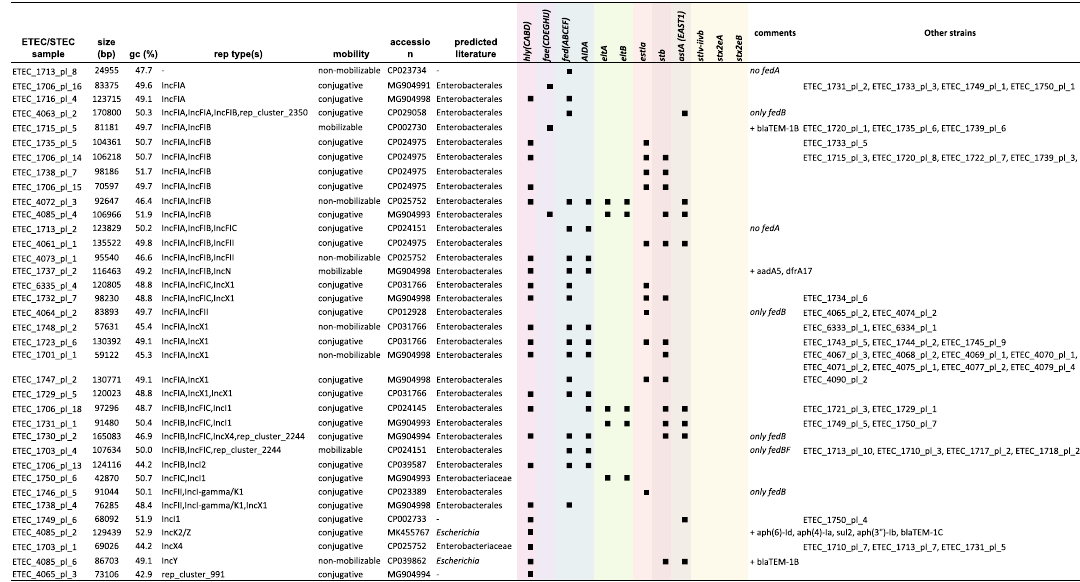
TABLE 2 In-depth characterization of virulence-encoding